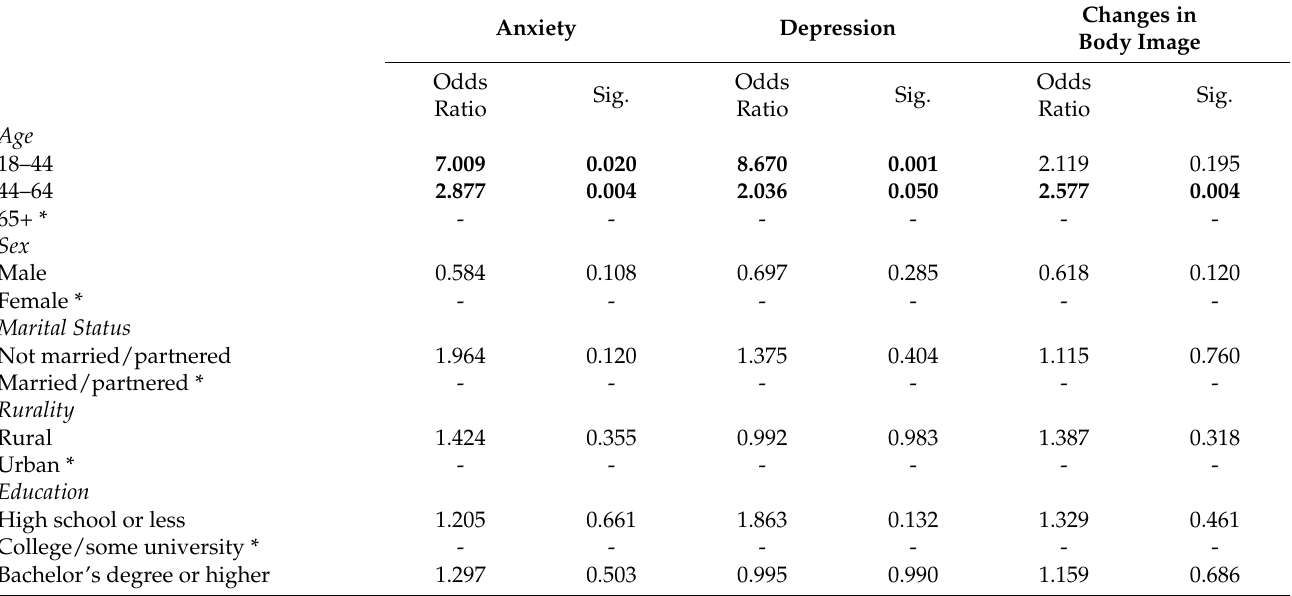
Table 7. Odds ratios from binary logistic regressions for melanoma